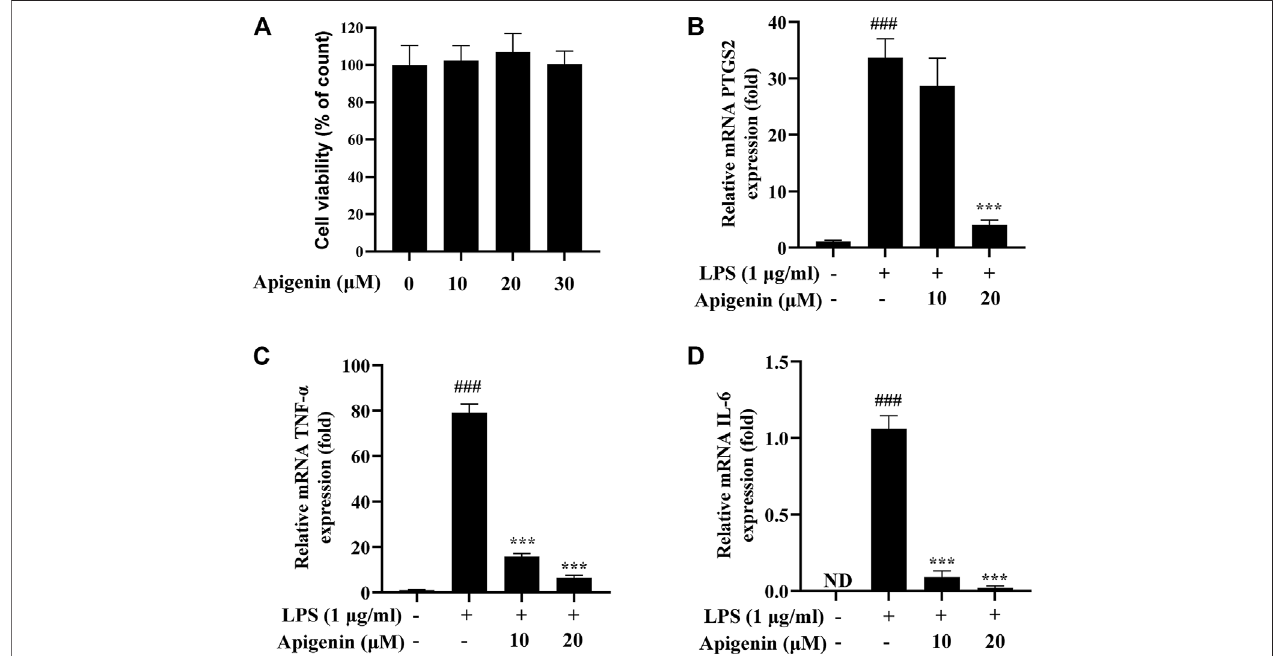
FIGURE8| TohokuHospitalPediatrics-1(THP-1)macrophagesweretreatedwithapigeninandlipopolysaccharide(LPS;1 μ g/ml)andsubsequentlyincubatedfor 18 h.TheeffectsofapigeninonthemRNAexpressionsofprostaglandinG/Hsynthase2(PTGS2),tumornecrosisfactoralpha(TNF- α ),andinterleukin6(IL-6)areshown. (A) Cell viability as determined by the CCK-8 assay. (B – D) The mRNA expressions of PTGS2 (B) , TNF- α (C) , and IL-6 (D) were detected by real-time PCR. Data are the mean ± SD from three separate experiments. ND , not detected. ### p < 0.001 versus control; *** p < 0.001 versus treatment with LPS alone.